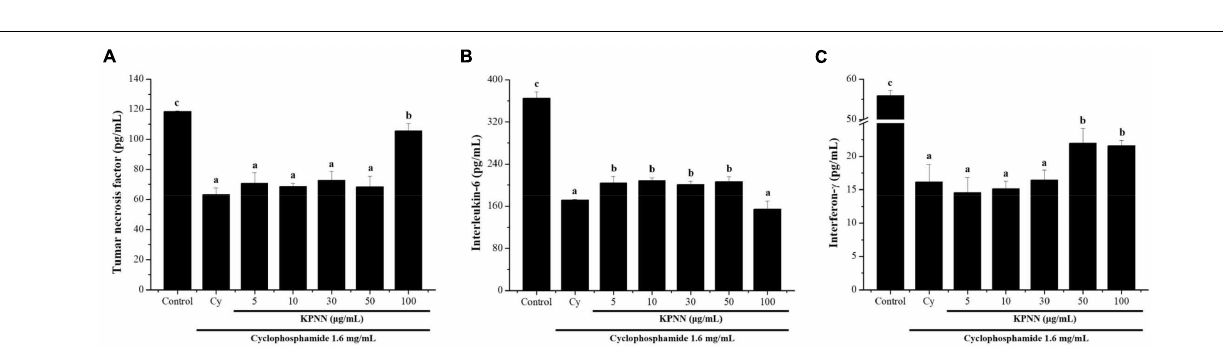
Frontiers in Nutrition |